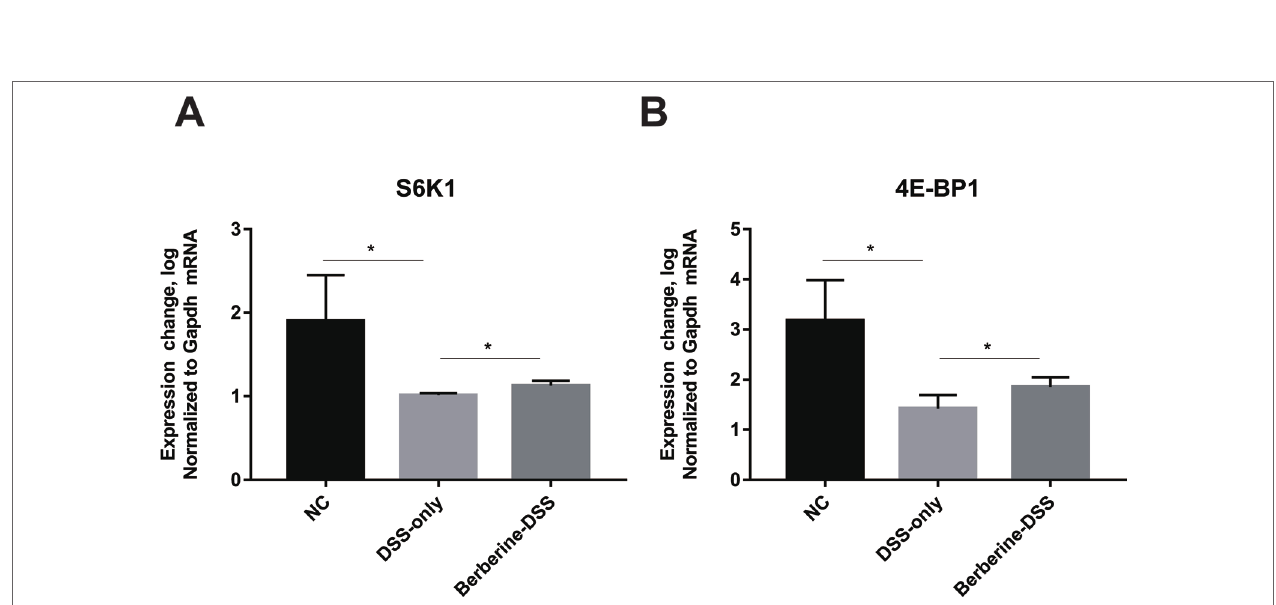
FIGURE 5 | Berberine had an effect on glutamine and glutamate metabolism. MetaboAnalyst software was used to reveal the relevant pathway involved in the berberine’s regulation of immune response.